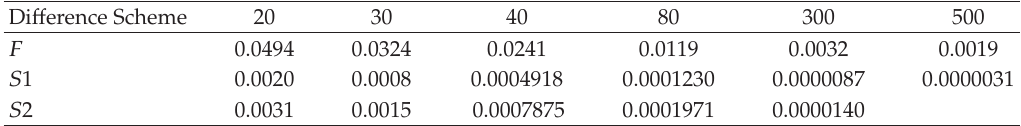
Table 1: Comparison of errors for approximate solutions.